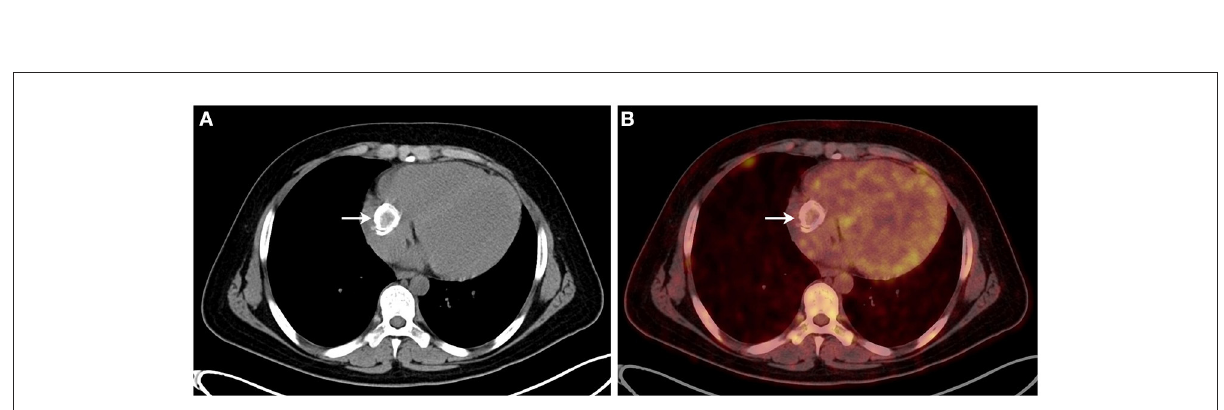
FIGURE3 (A,B) The 18F-fluorodeoxyglucose positron emission tomography combined with computed tomography showed that a dense circular shadow was in the right atrium abutting the tricuspid valve (32 × 34mm), and there was no increase in glucose metabolism.